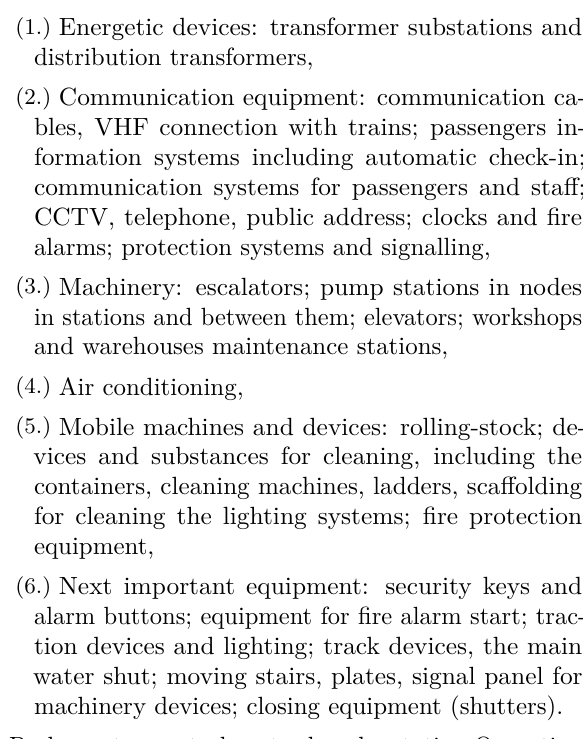
Figure 5. Control and controlled system in metro model station